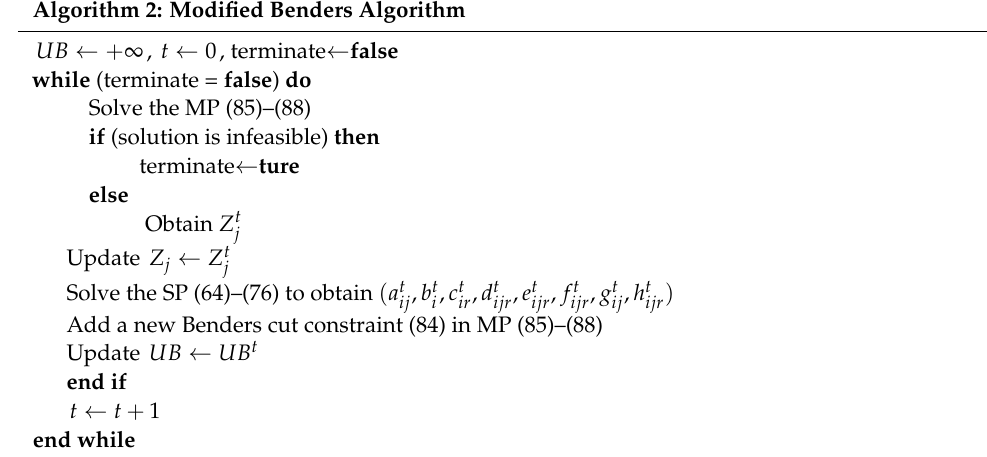
Algorithm 2: Modified Benders Algorithm